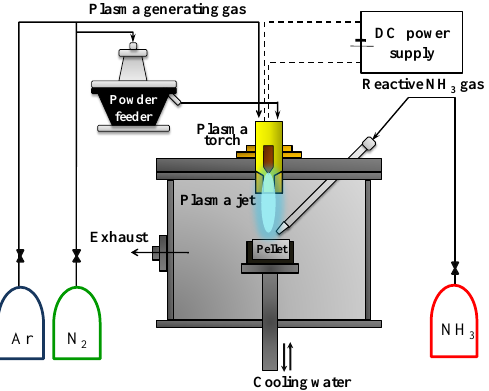
Figure 1. Experimental apparatus for the synthesis of GaN (gallium nitride) nanopowder by DC (direct current) non-transferred thermal plasma.